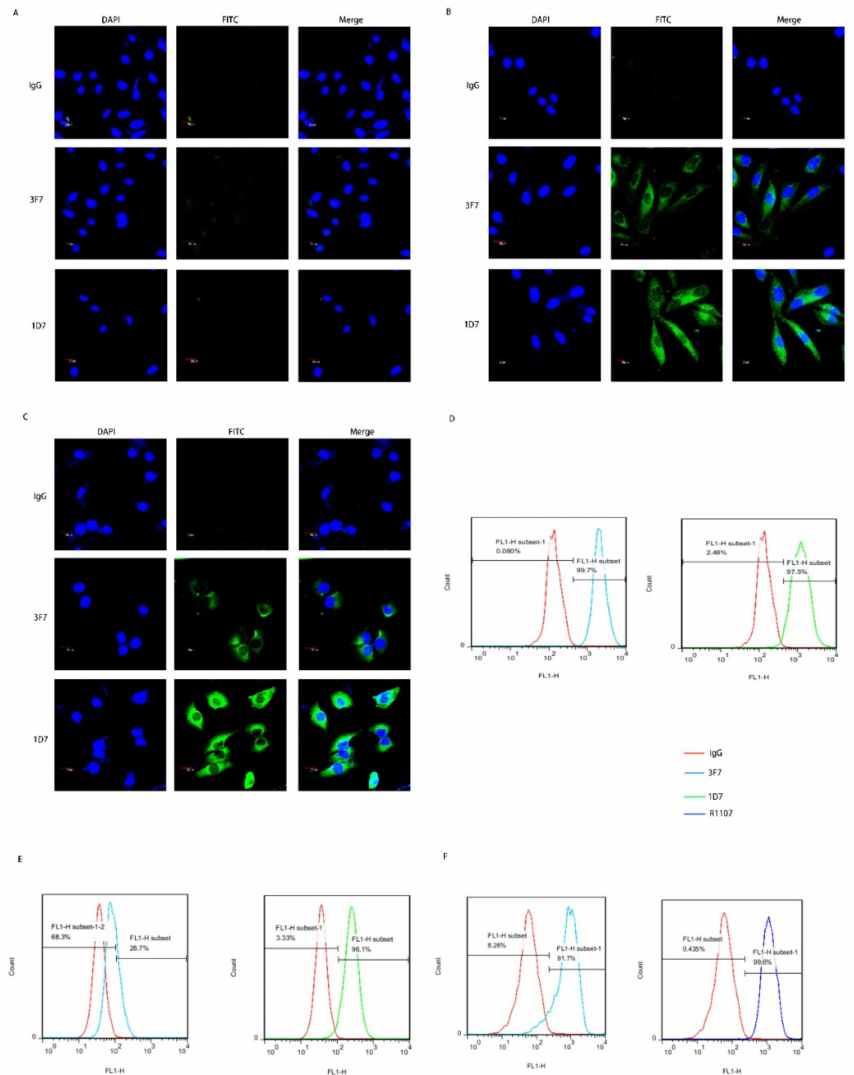
Figure 4. The 3F7 antibody specifically targeted the CD73 in vitro: ( A – C ) an indirect immunofluorescence assay showed the binding of antibody with CD73 in MCF-7, MDA-MB-231, and MDA-MB-468 at 630 × magnification, respectively, and ( D – F ) a flow cytometry analysis of the binding of antibody-CD73 on the surface of MDA-MB-468, MDA-MB-231, and 4T1 cells, respectively; R1107, an antibody targeting mouse or human CD73 protein. Data were representative of at least three independent